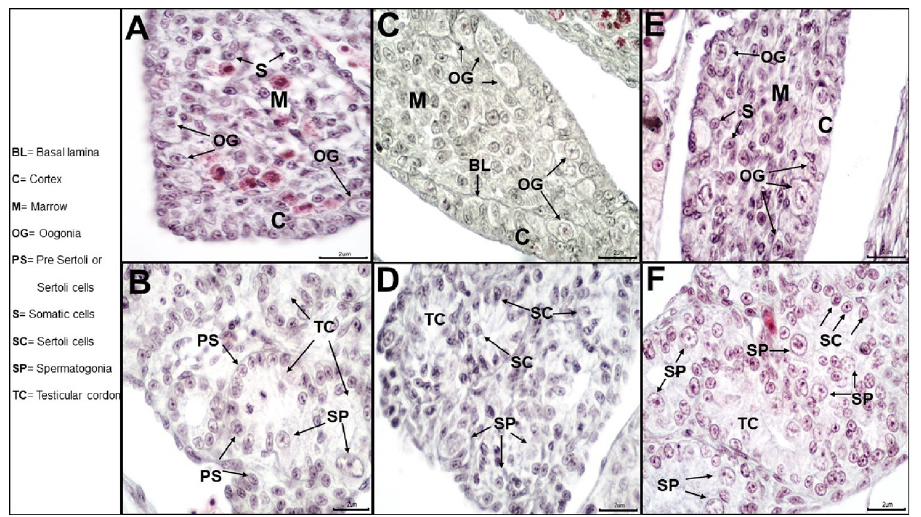
Fig 1. Ovaries and testes at stages 35–37 of development in B . vittatus embryos. a) histology of the ovary in stage 35. b) histology of the testis in stage 35. c) histology of the ovary in stage 36. d) histology of the testis in stage 36. e) histology of the ovary in stage 37. f) histology of the testis in stage